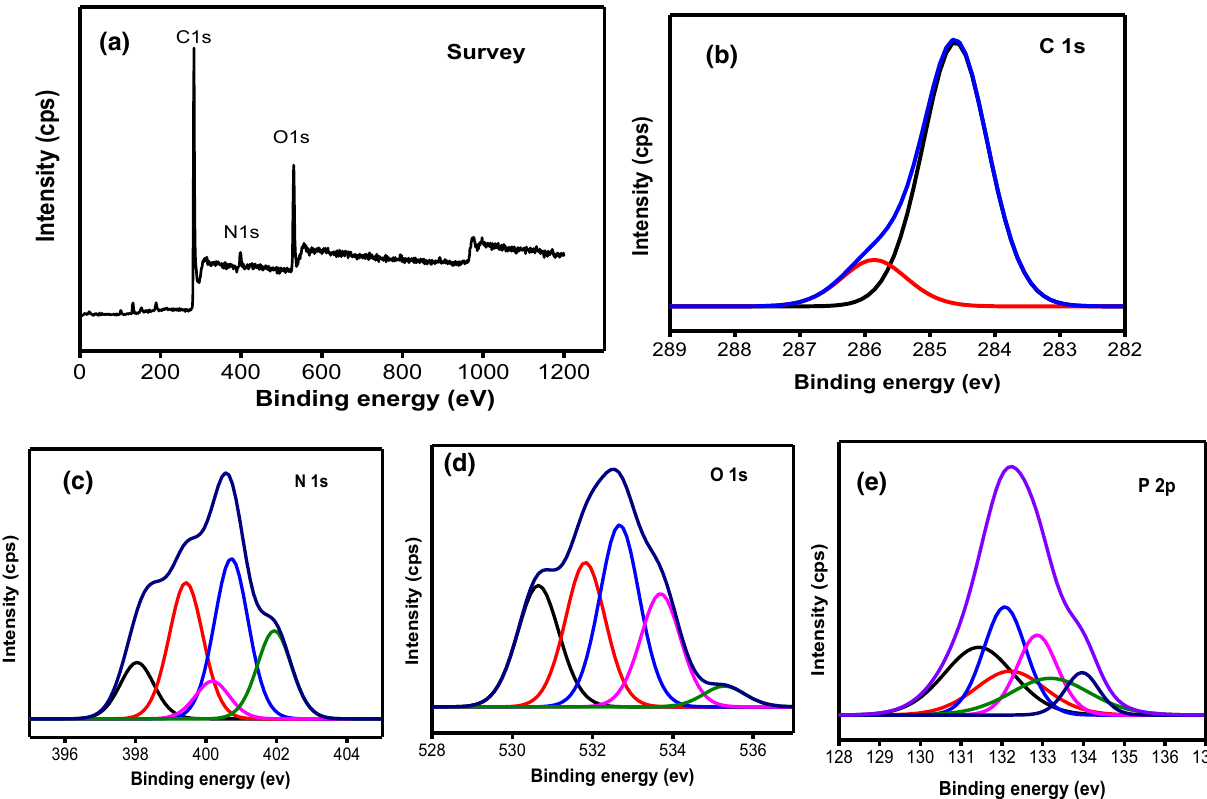
Fig. 4 XPS spectra of EDS/H 3 PO 4 -600 2:3. a wide scan, b C 1s spectra, c N 1 s spectra, d O 1s spectra and e P 2p